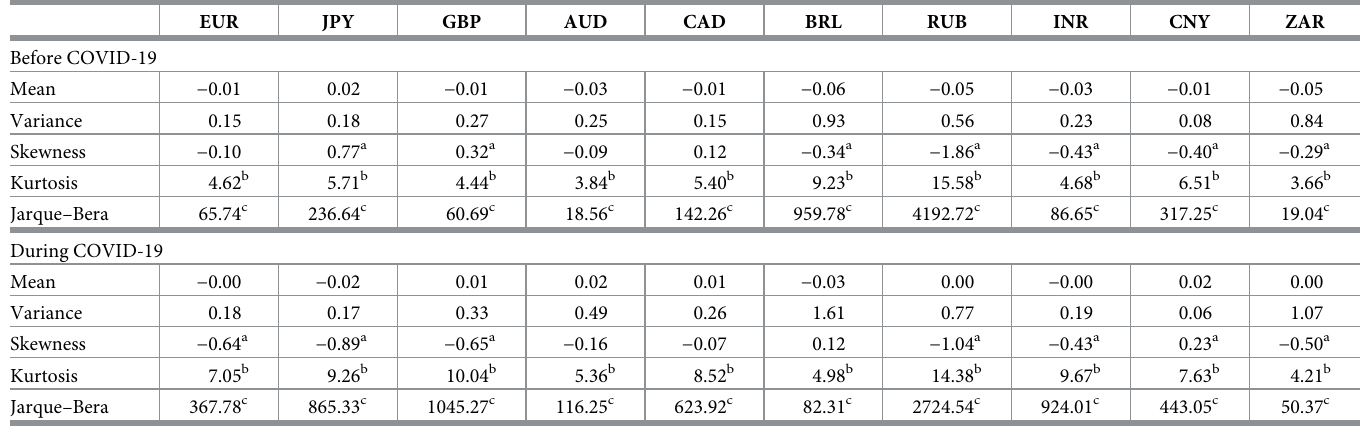
Table 2. Summary statistics of the returns of currency exchange rates.